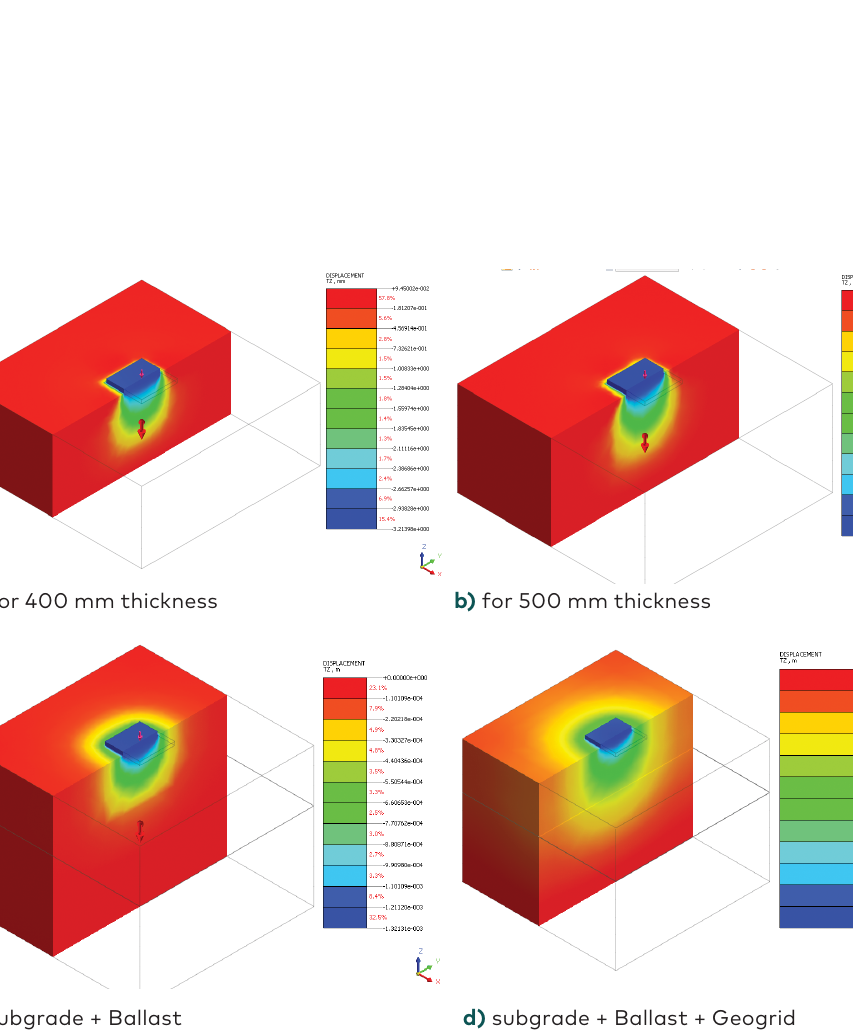
Figure 8. The analysed model of subgrade